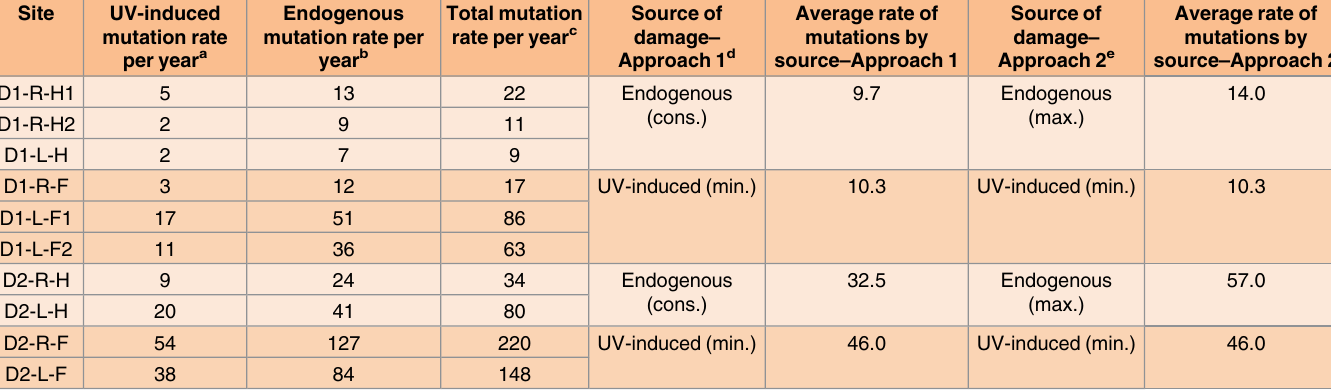
Table 1. Estimatesof rates of accumulation of endogenous and UV-induced mutations per